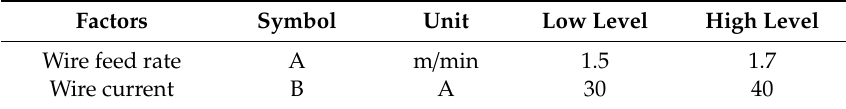
Table 5. Full factorial experimental design table. Table 4. Determining the level of factors used in the